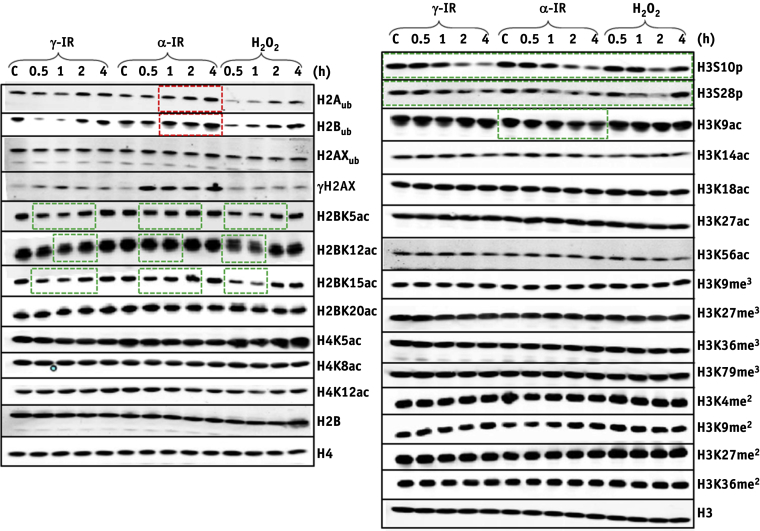
Analysis of histone post-translational modifications (PTMs) in response to γ-irradiation, α-particles, and hydrogen peroxide. HeLa cells were untreated (designated C), irradiated with 10 Gy γ-irradiation/α-particles or treated with 150 μM H2O2, and harvested at the time points indicated after treatment and purified histones analyzed by immunoblotting. Red boxes indicate increased levels of histone PTMs, whereas green boxes indicate reduced levels. Shown are representative images acquired from at least two independent experiments, and levels of the respective unmodified histone are shown as a loading control. (A color version of this figure is available at www.redjournal.org.)